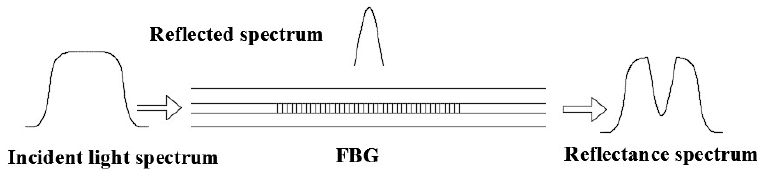
Figure 4. The structure and reflection principle of FBG.